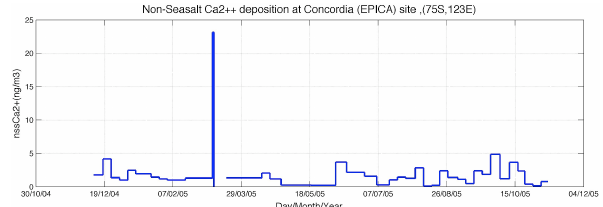
Figure 1: Non sea-salt calcium extracted from airborne aerosols measured at the Fig. 1. Non sea-salt calcium extracted from airborne aerosols mea- Concordia Station site (Dome C, Concordia project) during the 2004-2005 sured at the Concordia Station site (Dome C, Concordia project) campaign. The largest peak corresponds to a 24 hour filter measurement from during the 2004–2005 campaign. The largest peak corresponds 9UTC March 8, 2005 to 8UTC March 9, 2005. to a 24h filter measurement from 09:00UTC 8 March 2005 to 08:00UTC 9 March